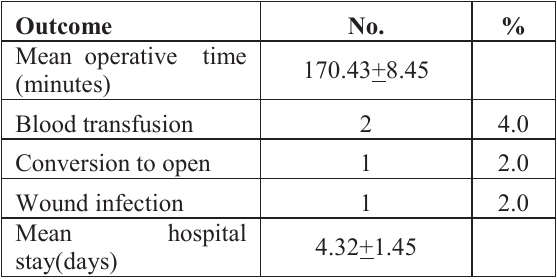
Table-2: Outcomes recorded after